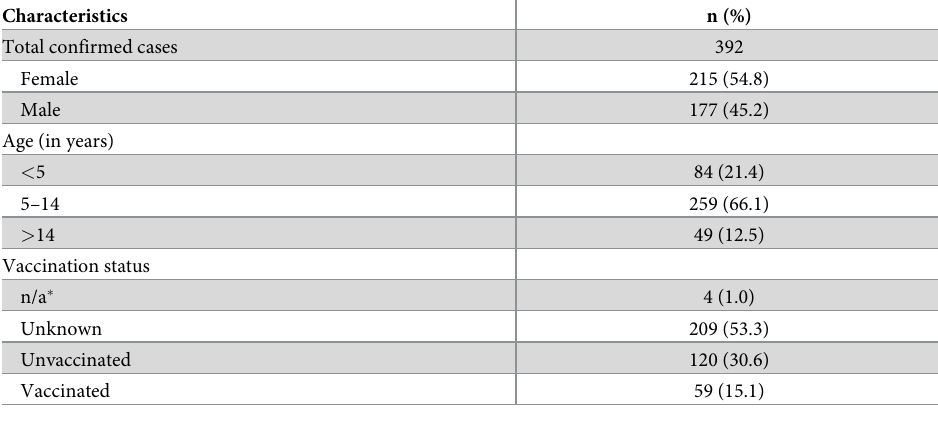
Table 2. Characteristics of confirmed diphtheria cases in Haiti, December 2014 –June